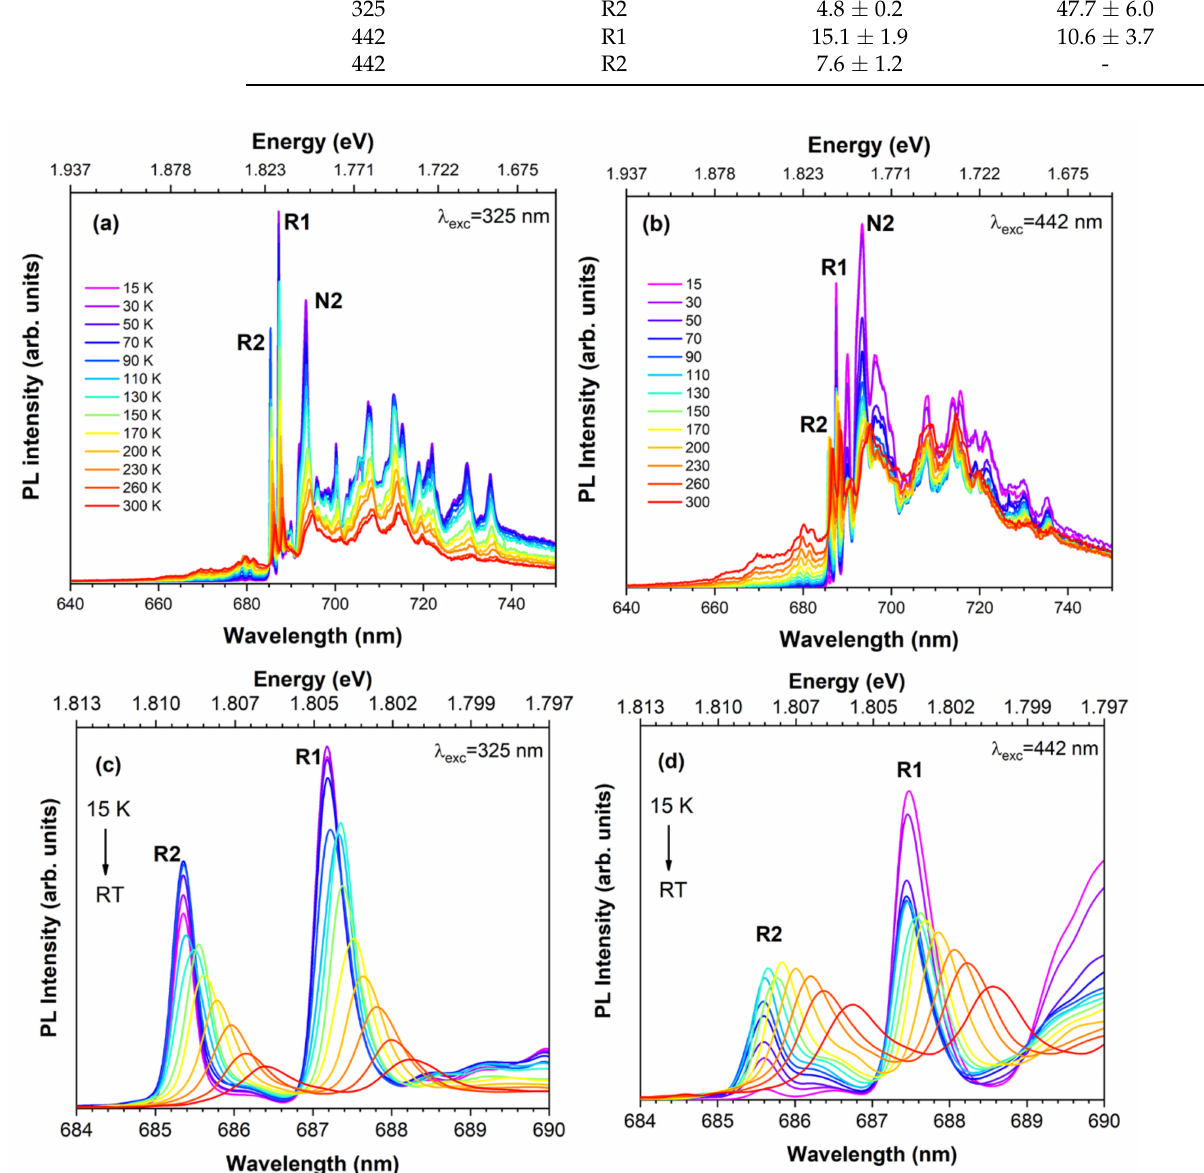
Figure 8. Temperature-dependent PL spectra of ZGGO:Cr obtained under ( a ) 325 nm and ( b ) 442 nm of excitation. ( c , d ) Corresponding enlarged spectra of the R-lines region upon subtracted